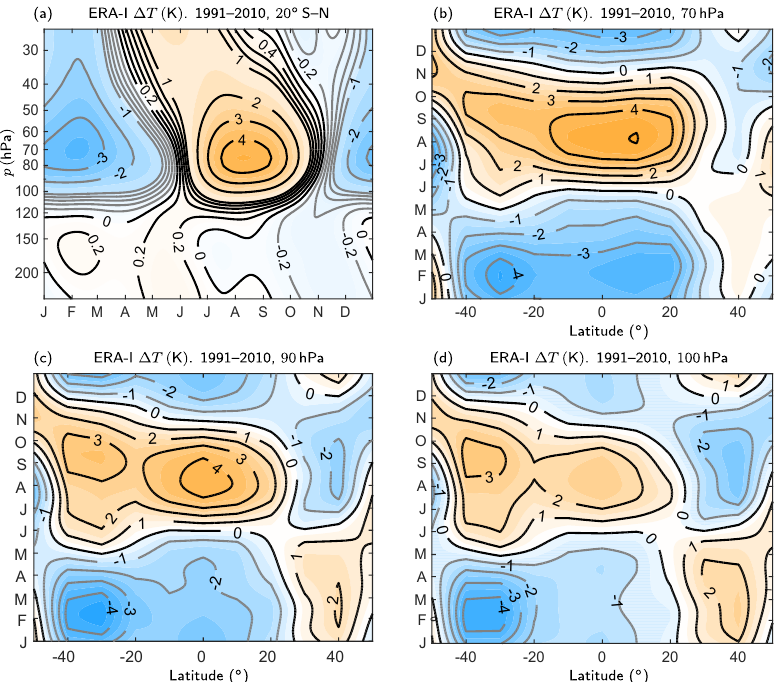
Figure 1. Climatology of the annual temperature cycle in ERA-Interim constructed by averaging from 1991 to 2010: (a) between 20 ◦ N and 20 ◦ S, (b) at 70hPa, (c) at 90hPa, and (d) at 100hPa. The marks for the months indicate the first day of each month. The values of the temperature are shown by solid contours with contour values labelled explicitly. The coloured contours are shown at intervals equal to half of the solid contour interval. These conventions are followed in all of the figures in the